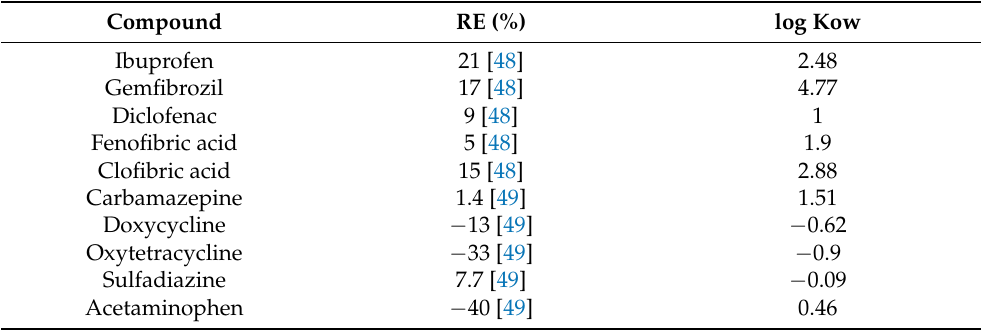
Table 1. Removal efficiencies of hydrophilic pharmaceuticals and their log Kow factors in filtra- tion